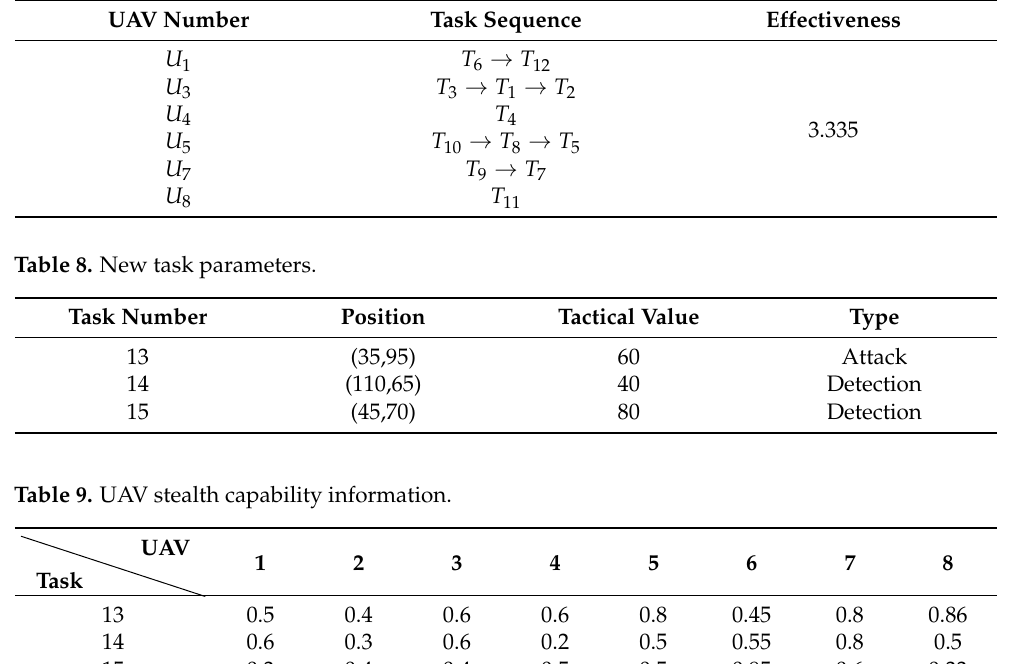
Table 7. Task pre-allocation scheme.